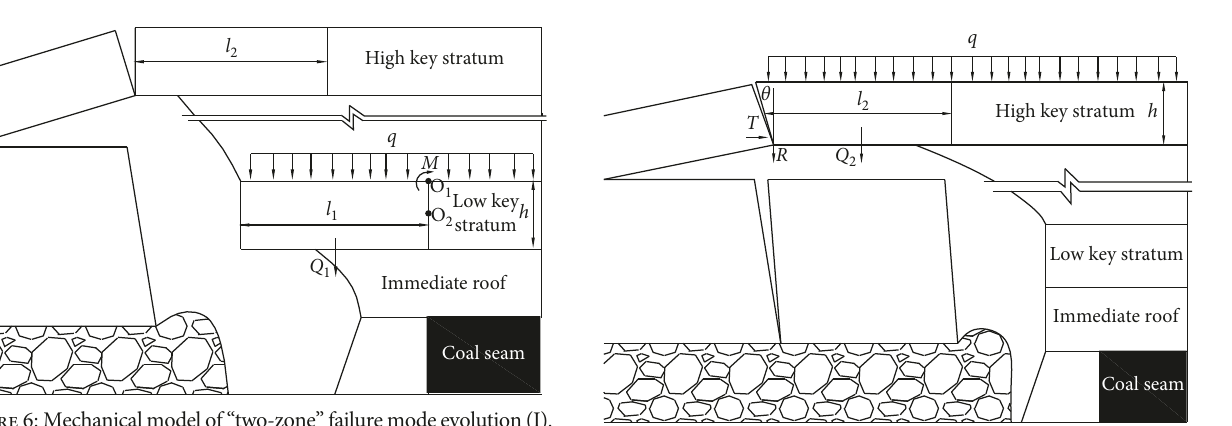
Figure 7: Mechanicalmodelof“two-zone”failuremodeevolution(II).